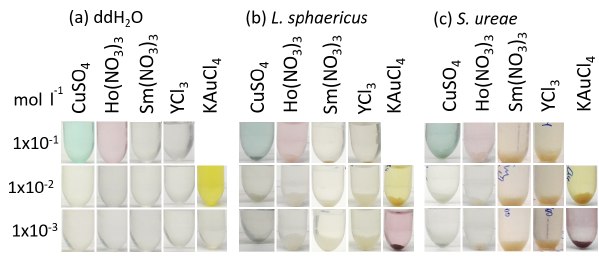
Figure 1. Incubation of L. sphaericus JG-B53 and S. ureae ATCC 13881 in different analyte solutions at three concentrations. The ref- erence was a metal salt solution in water without bacteria cells.